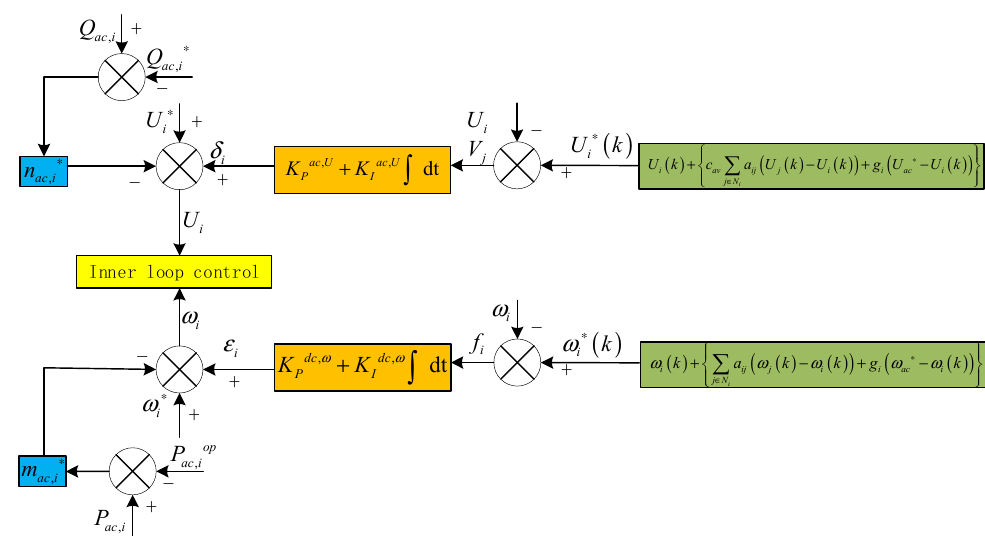
Figure 3. AC subnet control block diagram.